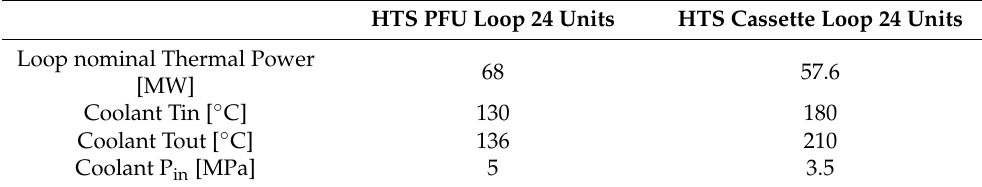
Table 1. PHTS summary data for PFU and cassette